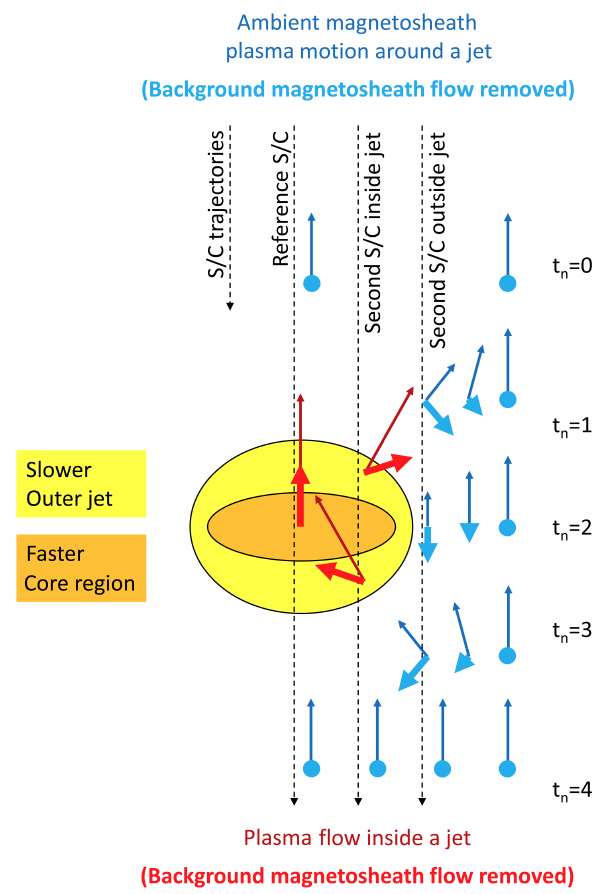
Figure 6. Sketch of plasma flow patterns inside (red) and outside (blue) a magnetosheath jet. The flows are depicted by thin solid arrows resembling those in Figs. 3a and 5a. Differences from the background magnetosheath flow are illustrated by thick arrows and dots in lighter colors (compare to Figs. 3b and 5b). The jet plasma itself is shown to be layered, with slower plasma (in yellow) outside a faster core region (in orange). The upper part corresponds to the magnetosheath ahead of the jet ( t n = 0), whereas the lower part of the sketch depicts the trailing magnetosheath region ( t n =